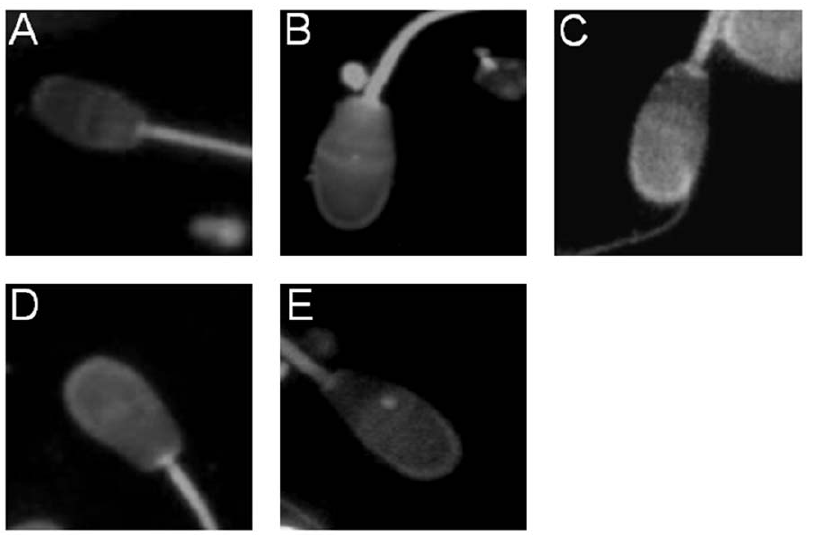
Figure 3. Effect of dietary treatment on sperm membrane cholesterol. Fluorescence micrographs showing cholesterol content in plasma membrane of ejaculated rabbit spermatozoa detected by filipin probe. Images correspond to filipin-stained sperm cells ( 6 630) from NCR (A), OO (B) HCR (C), K HCR (D) and K HCR + K OO (E). Compare the strong signal detected in HCR (C) with the one from the K HCR + K OO (E). The experiment was performed at least three times with 20 sperm from each animal.